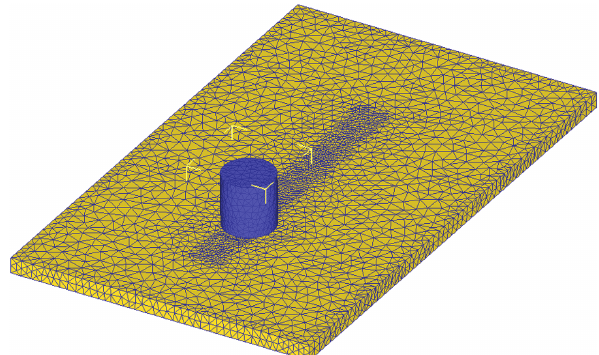
Figure 1: Finite element model.